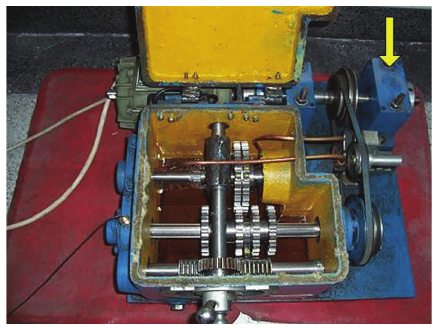
Figure 6: The rolling bearing experiment